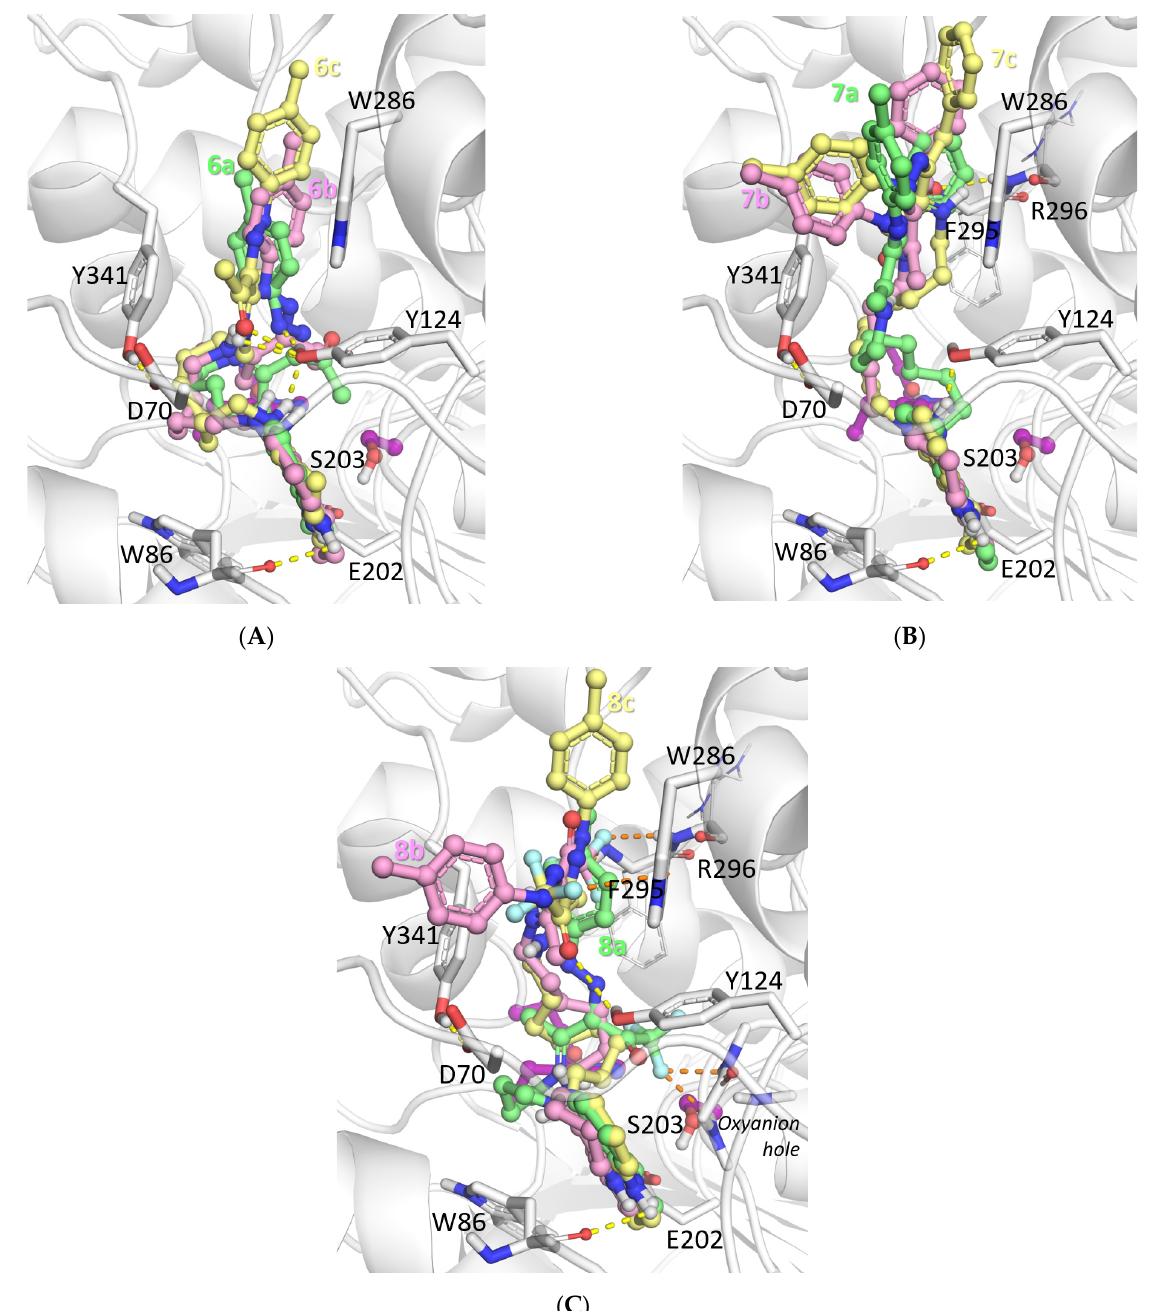
Figure 4. Molecular docking to the active site of AChE of conjugates 6a–c ( A ), 7a–c ( B ), and 8a–c ( C ). Carbon atoms of compounds 6–8a are colored green, 6–8b —pink, 6–8c —yellow. In the case of BChE, binding is much more uniform with the carbonyl oxygen atom of the keto group in the oxyanion hole (Figure 5, A–C). While ligands with increasing linker length occupy similar positions in the BChE active site, the tacrine fragment could form π -cation and π - π stacking interactions with Tyr332 or Trp82, supported by ionic interactions and hydrogen bonds with the Asp70 or His438 main chain oxygen atom, re- spectively. In the case of compounds 7a–c, there are additional π - π or T-stacking